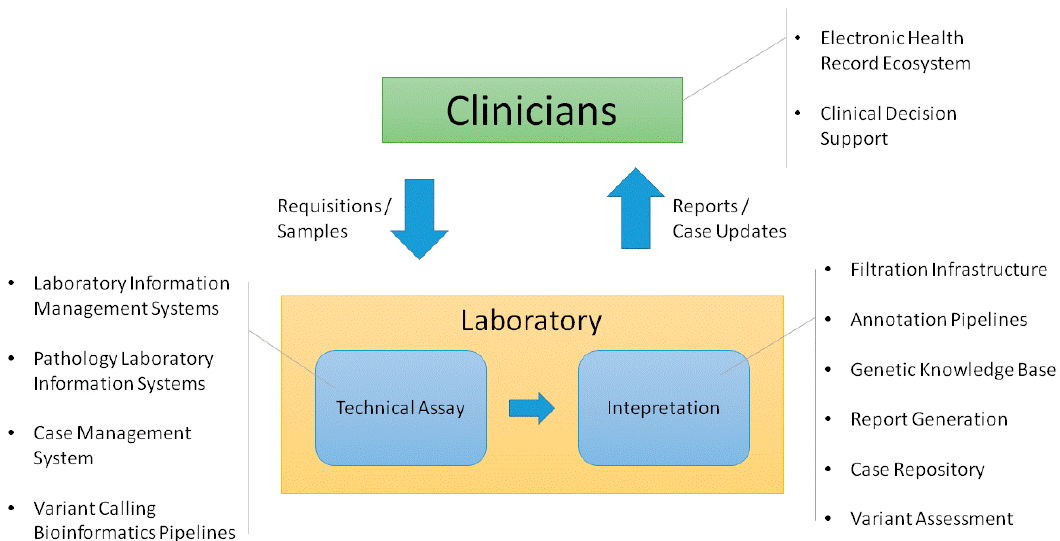
Figure 1. System functionality required to support the clinical genetic testing process flow.